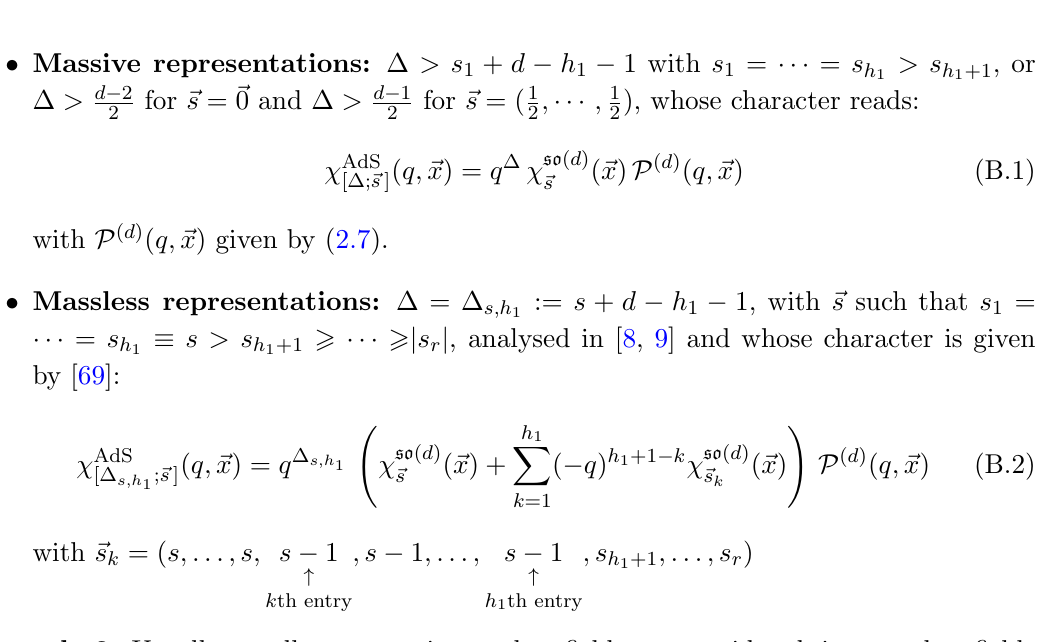
Figure 4 . Repartition of the massive scalar (cid:12)elds in dS d +1 discussed above, as a function of the conformal weight (cid:1) c . Massive (cid:12)eld in the principal and complementary series are depicted respectively by a red and a green line, whereas the blue dots indicate a discrete collection of representations in the complementary series with (cid:1) c = d (cid:6) ‘ that would correspond to higher order 2 singletons and their shadows in AdS d +1